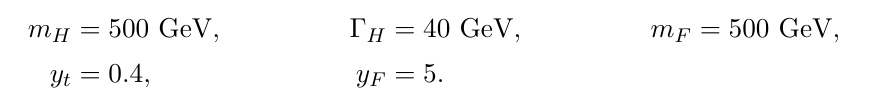
Figure 7 . Partonic cross section for gg interference, normalised to the t (cid:22) t background, computed from EFT and from the exact one-loop